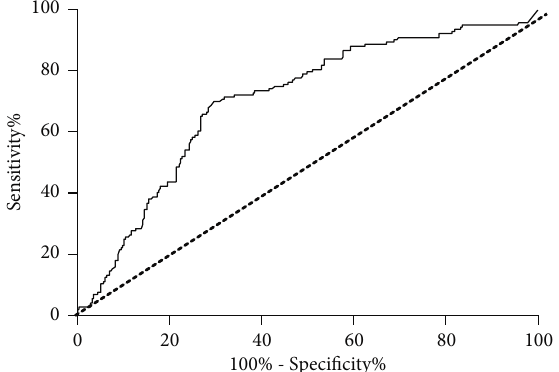
Figure 2: Receiver operating characteristic (ROC) curves for the prediction of HOMA-IR by serum AMH